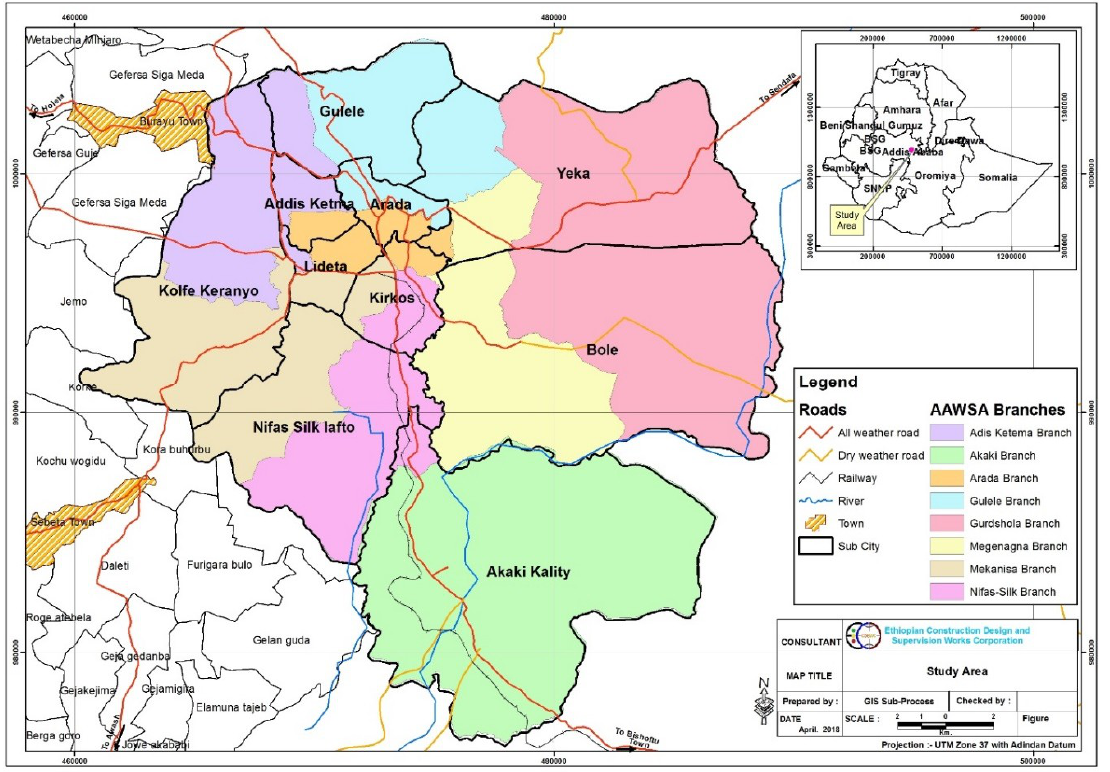
Figure 2. Map of Addis Ababa, Ethiopia.